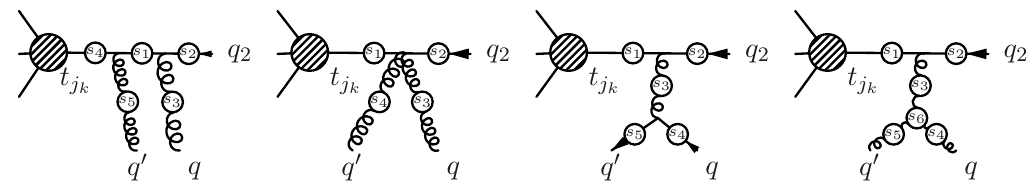
Figure 8 . Diagrams with double collinear emission in direction j . The insertions s k show possible attachments of the soft line. The part of the diagram in direction i is not shown. Also the crossed diagram corresponding to the (cid:12)rst one with momenta q and q 0 interchanged in not shown. where in the last two lines we have expanded in the small o(cid:11)-shell regulators q 2